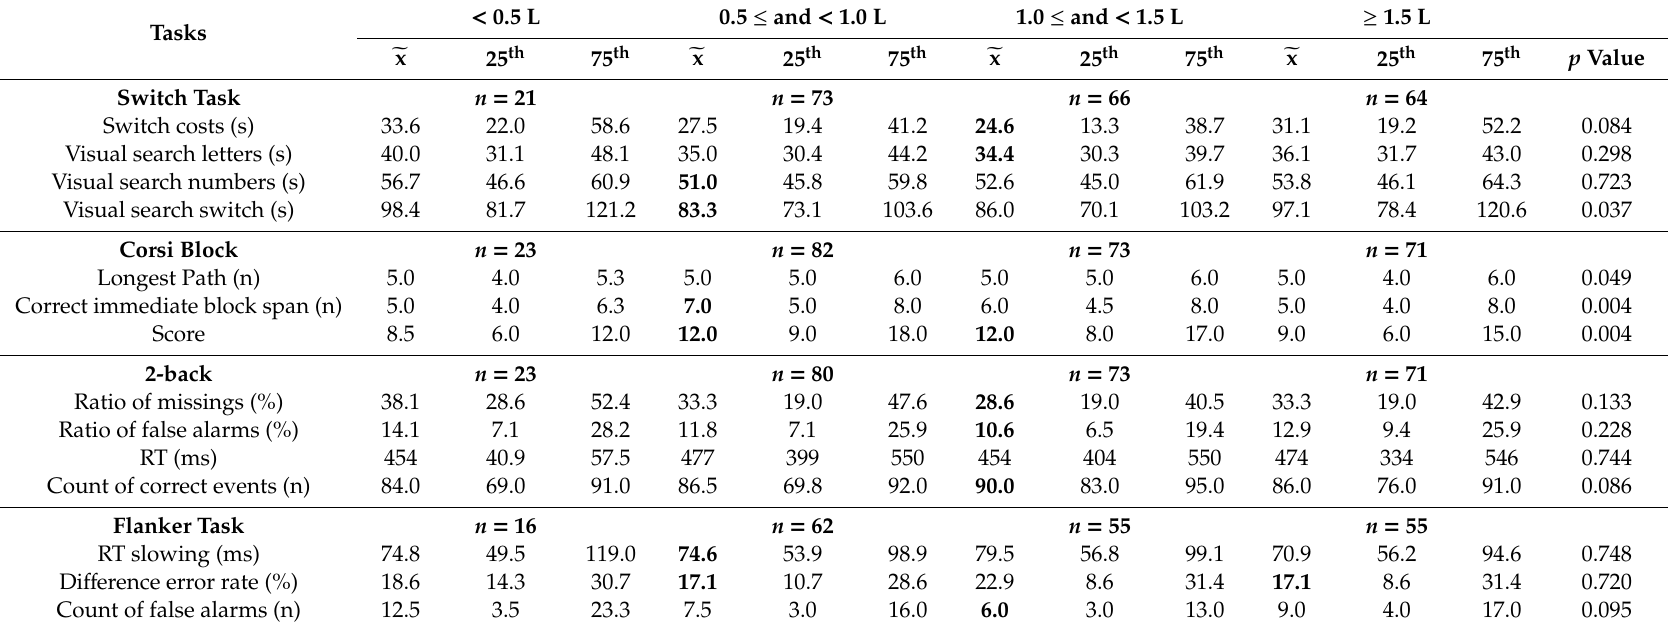
Table 2. Results of the cognitive tasks by water consumption categories in the total sample ( n = 250).